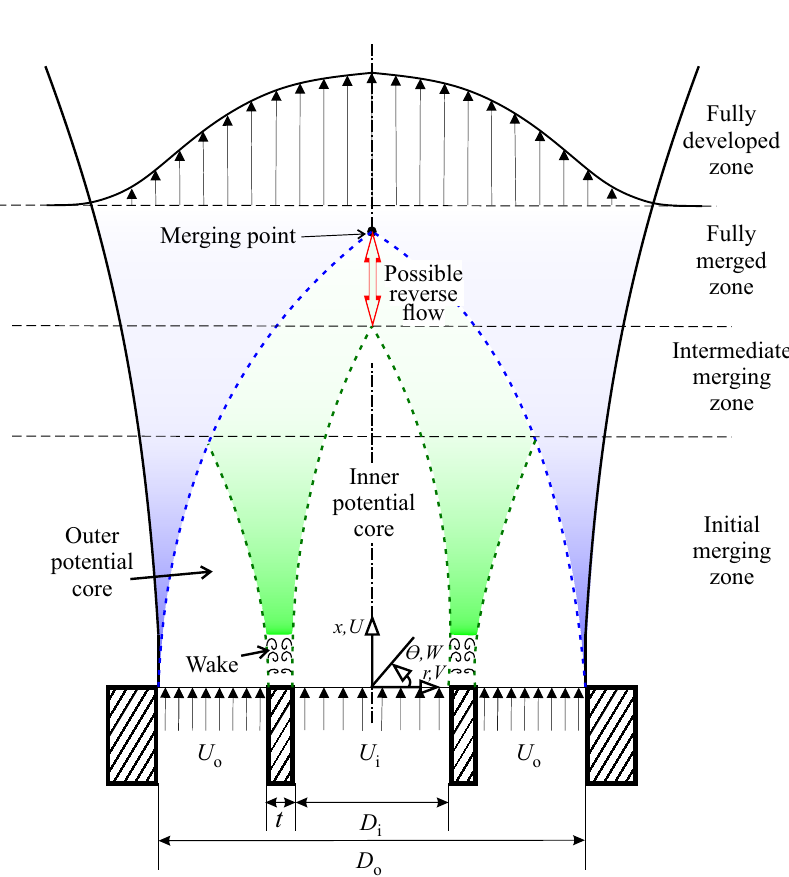
Figure 1. Coaxial jet nozzle configuration and different identified near-field flow regions and zones. Partially adapted from [14,17]. Green and blue shaded areas represent the inner and the outer mixing layers,